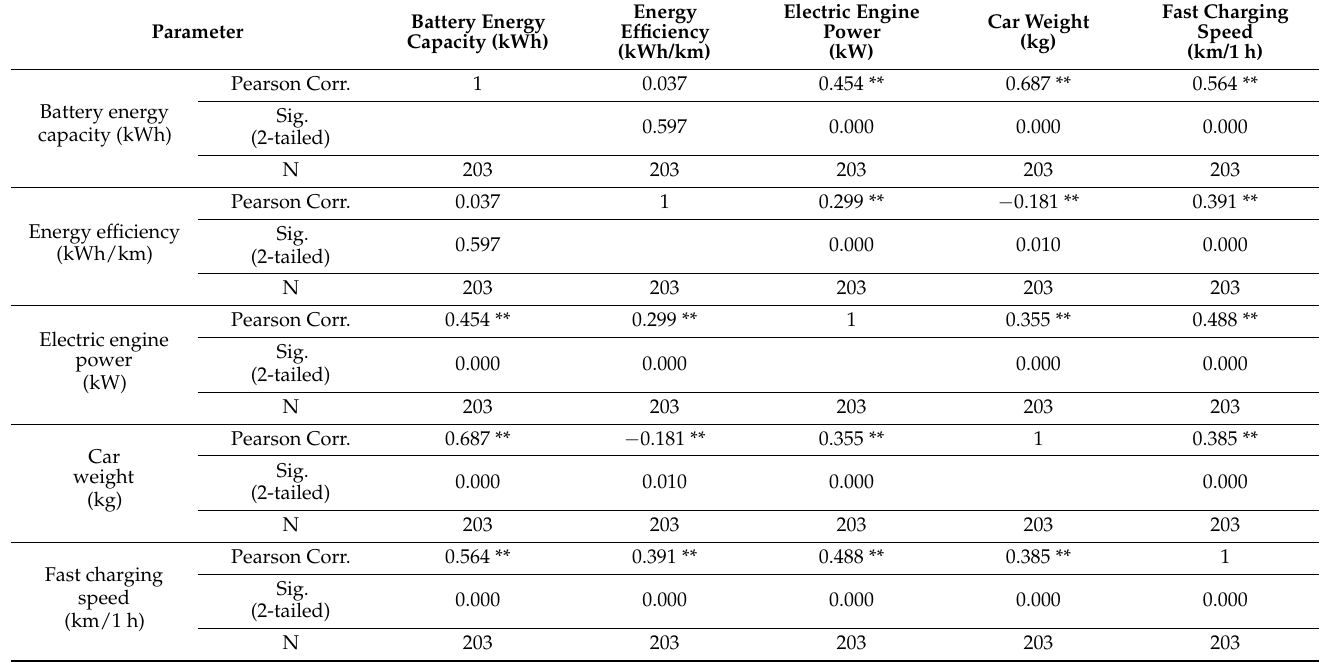
Table 5. Correlation coefficients between the technical parameters.